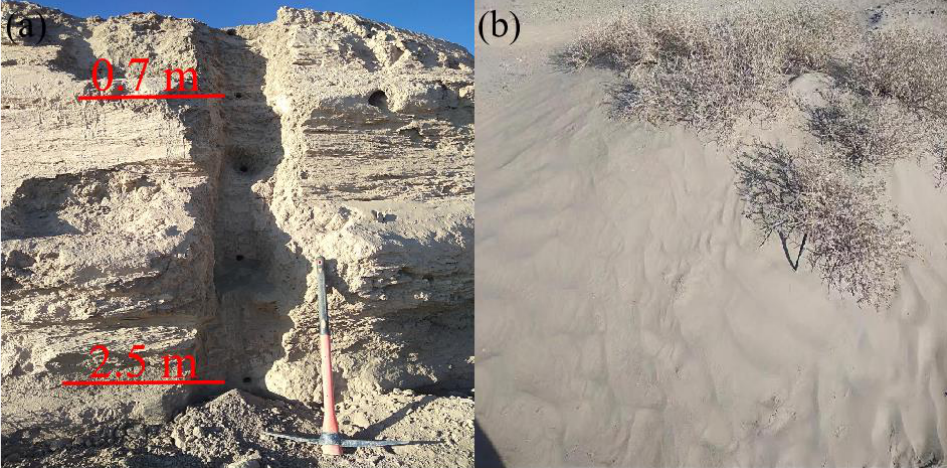
Remote Sens. 2022 , 14 , 5628 Figure 3. The Ta er Temple ( a ) in Suoyang City ruins, and the surrounding yardangs ( b ).